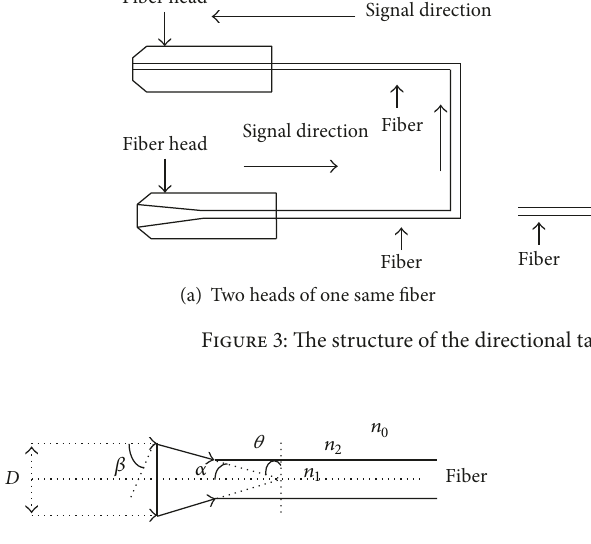
Figure 4: The structure of the new tapered optical fiber connector.